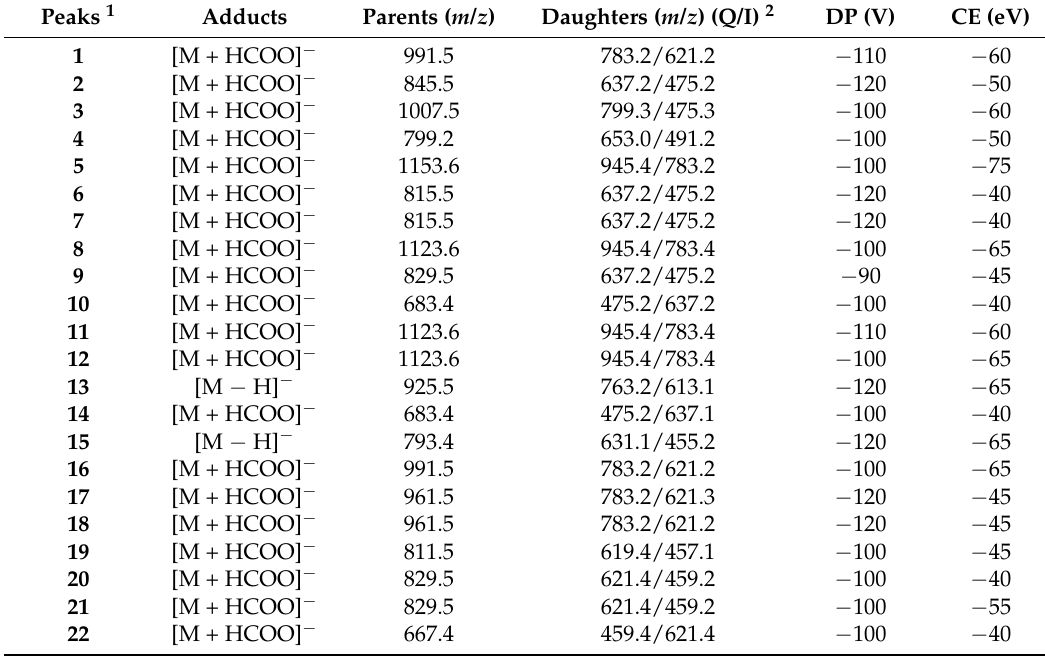
Table 1. The optimized MRM parameters and transitions for each analyst in UPLC-ESI-MRM-MS. Peaks